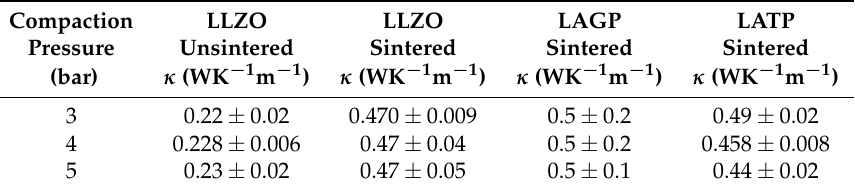
Table 4. Thermal conductivity values of different solid state